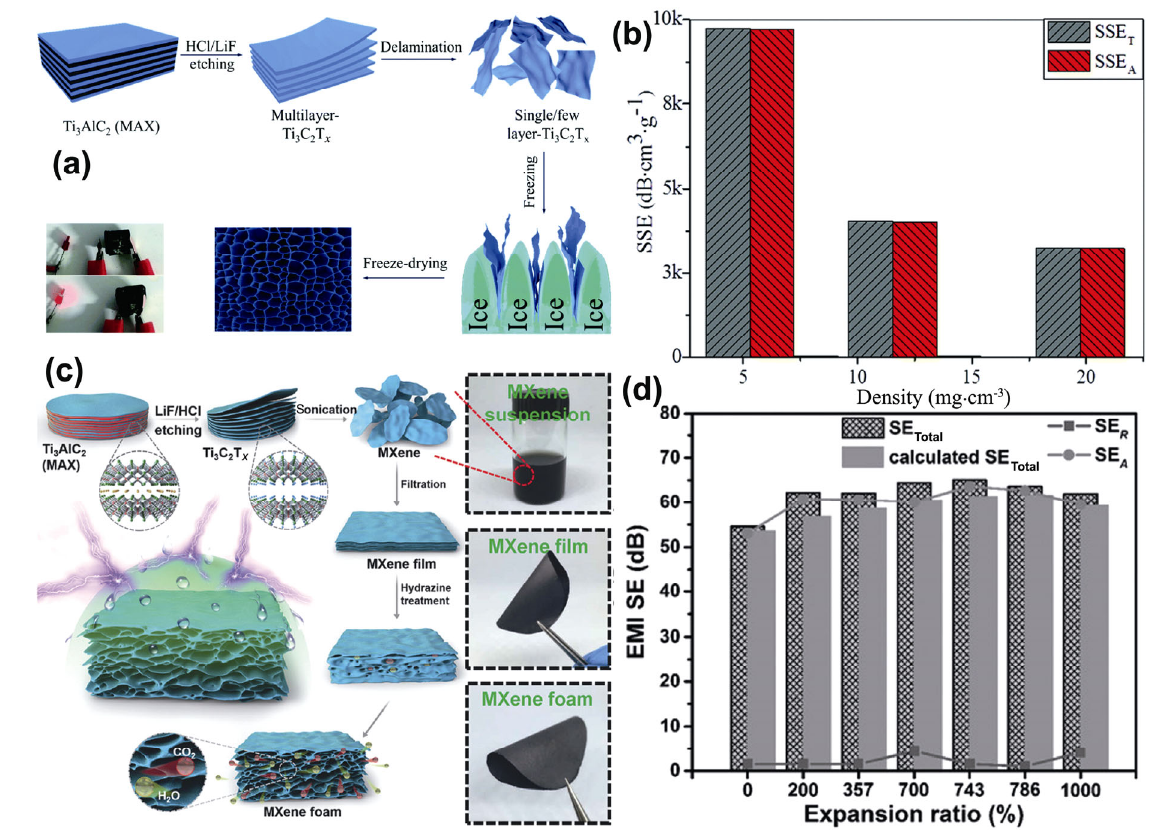
Fig. 30 (a) Flowchart for fabrication of MXene aerogels and (b) EMI SSE of MXene aerogels at 8.2 GHz. Reproduced with permission from Ref. [255], © Royal Society of Chemistry 2019. (c) Illustration of the fabrication of the hydrophobic and flexible MXene foam. (d) Effects of the expansion ratio on the measured and calculated EMI SE of the MXene foams. Reproduced with permission from Ref. [256], © WILEY-VCH Verlag GmbH & Co. KGaA, Weinheim